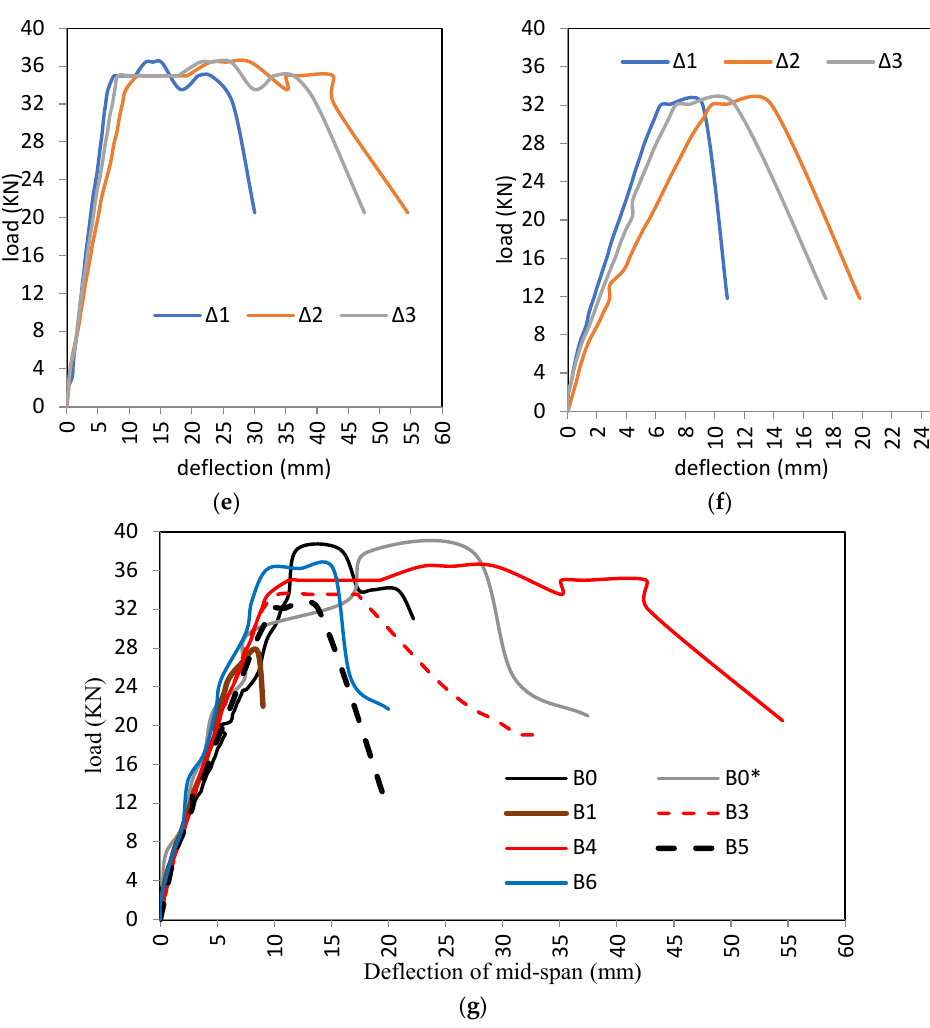
Figure 19. Load–deflection curves of the beams of G1. ( a ) B0; ( b ) B1; ( c ) B2; ( d ) B3; ( e ) B4; ( f ) B5; ( g ) ∆2 for all beams of G1.